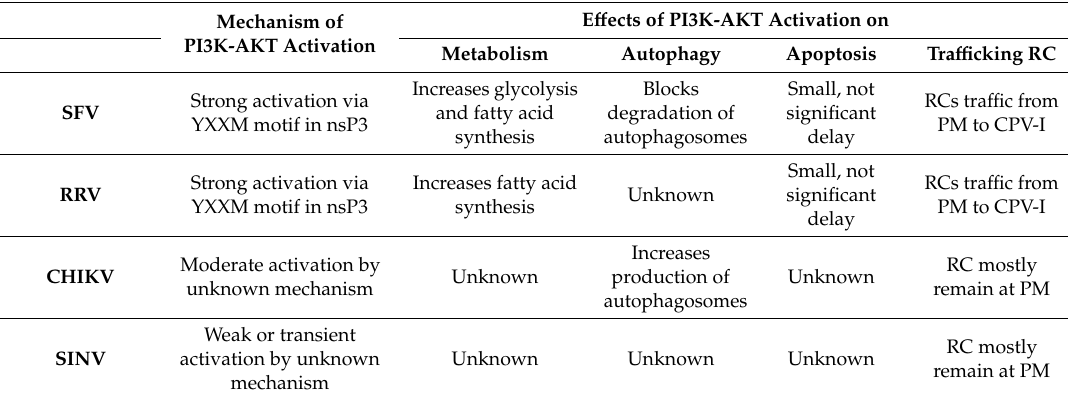
Table 1. Mechanisms and E ff ects of PI3K-AKT